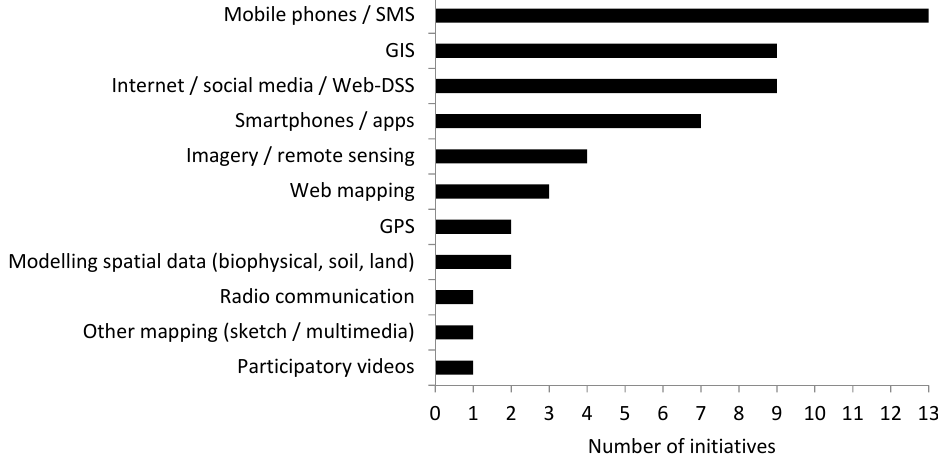
Figure 2. Technologies featured in reviewed AGI initiatives.